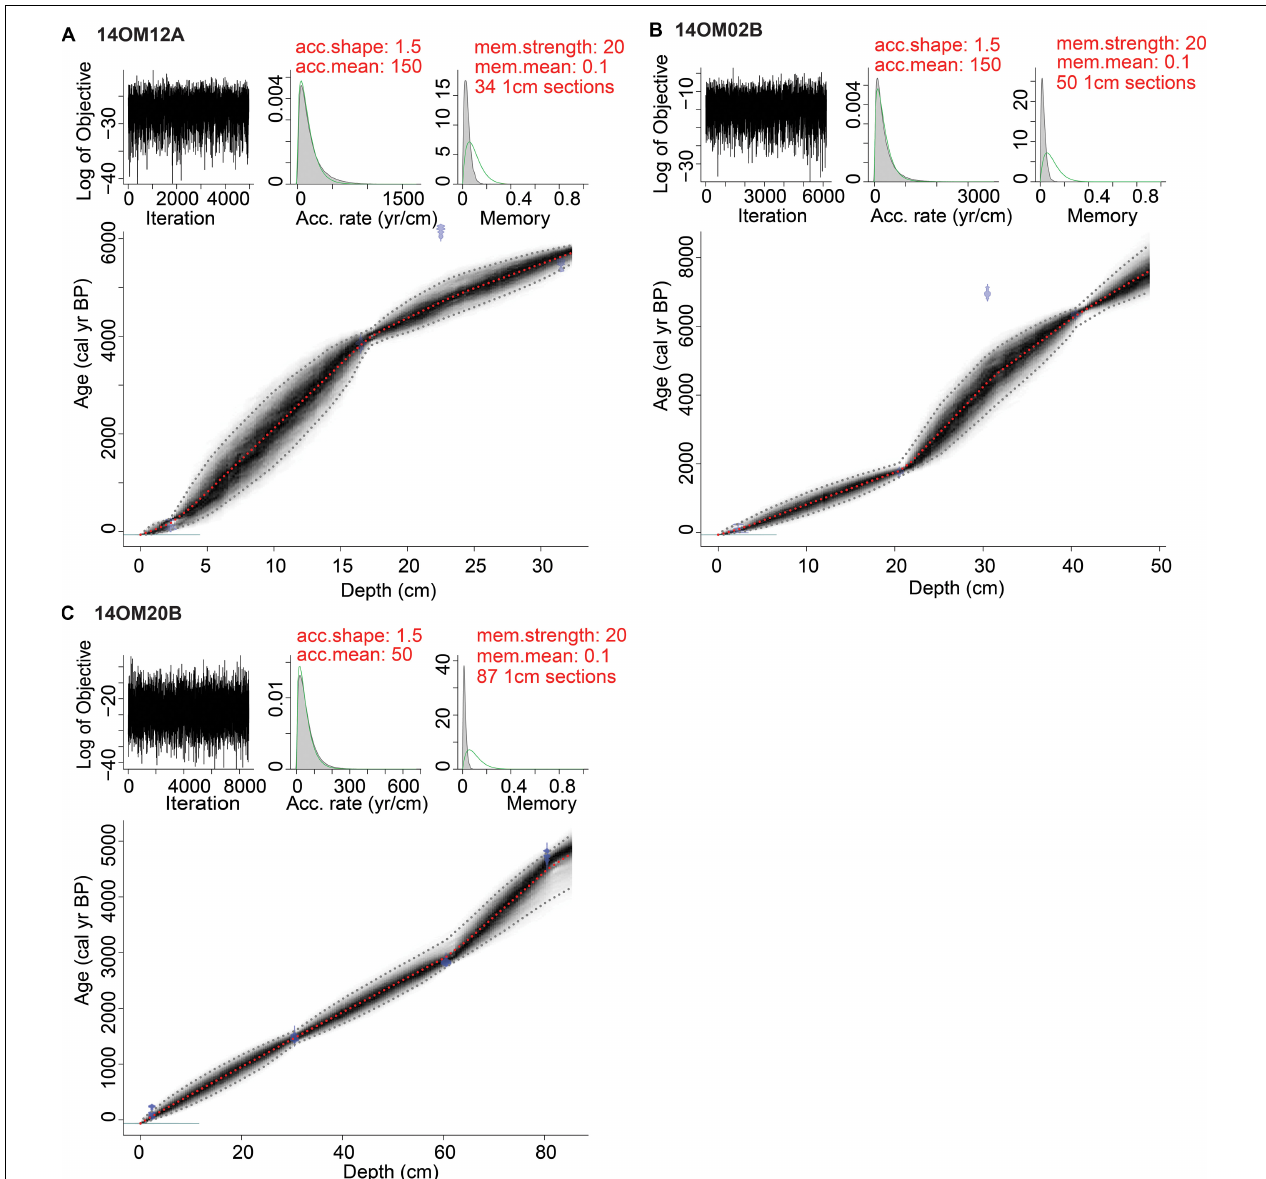
FIGURE 2 | Age–depth models of (A) core 14OM12A from typical tundra, (B) core 14OM02B from forest tundra and (C) core 14OM20B from open larch forest in the Omoloy region, Arctic region of northern